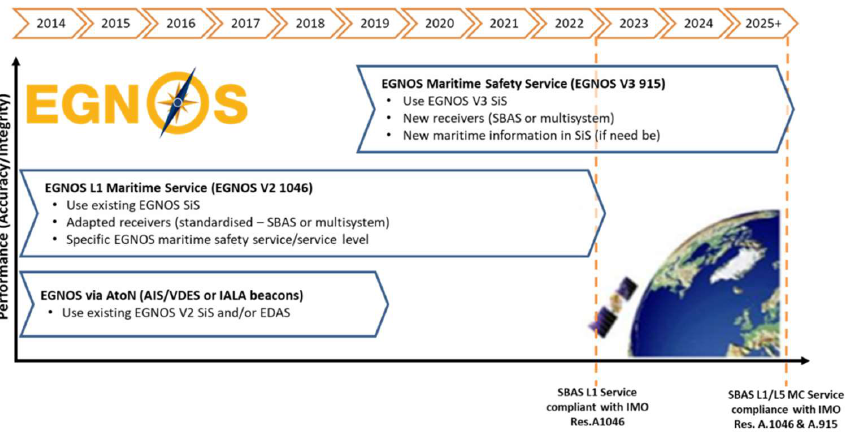
Figure 4. High-level European Geostationary Navigation Overlay Service (EGNOS) roadmap for maritime domain.